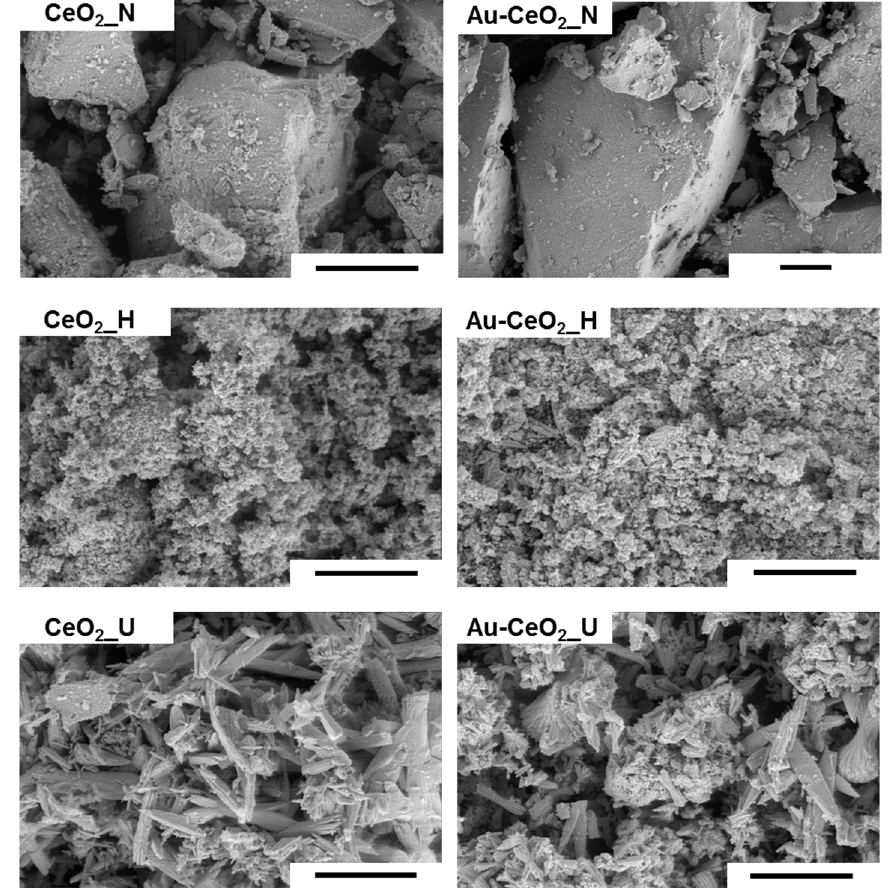
Figure 3. SEM images of catalysts. Scale bars represents 10 µm.